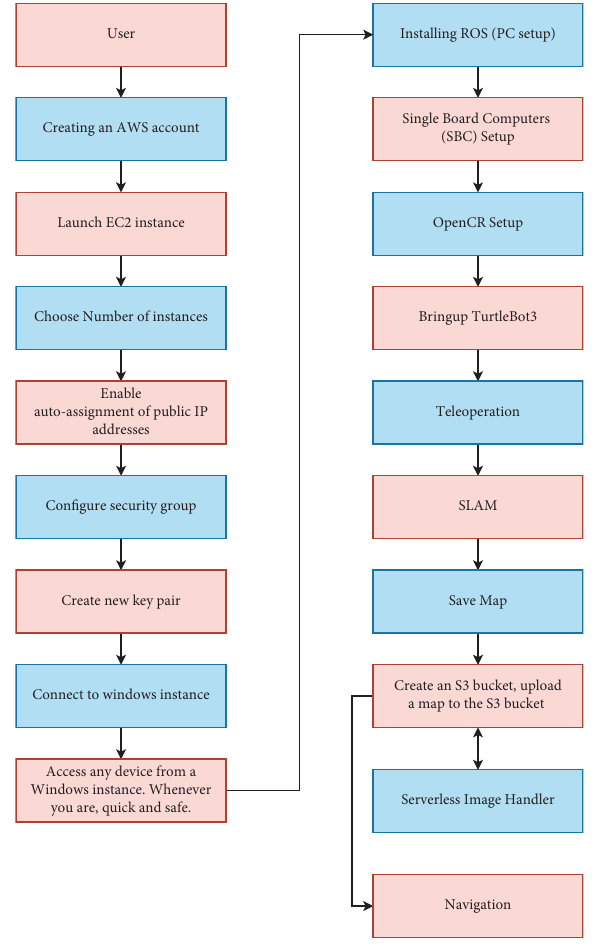
Figure 4: SLAM technique procedure in